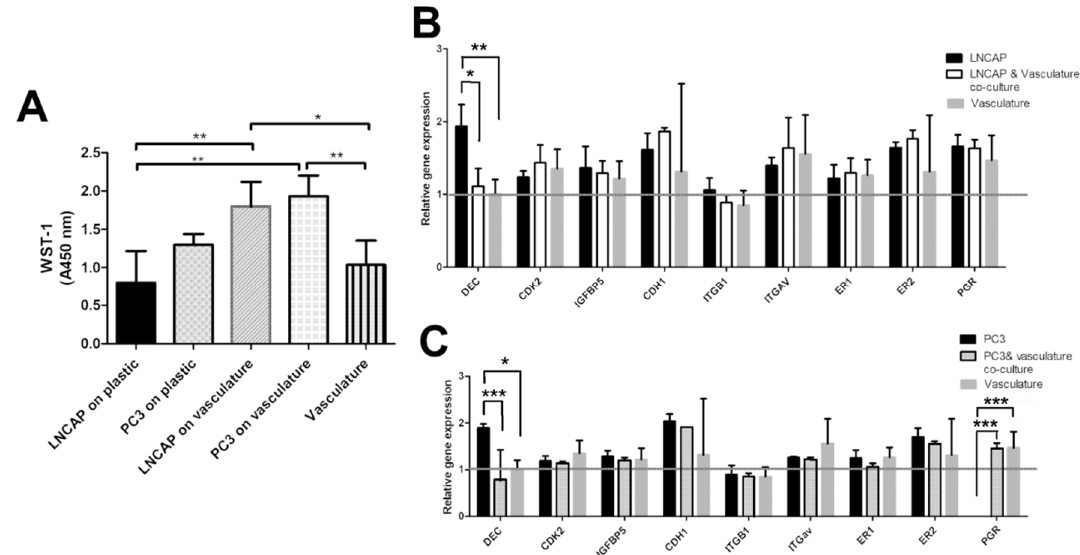
Figure 3. ( A ) Bar graph showing relative cell numbers in different cultures measured with WST-1. Difference between LNCAP and PC3 proliferation is smaller when grown on vasculature compared to plastic. Gene expression results of ( B ) LNCAP and ( C ) PC3 cells grown on plastic and on a vasculature platform. Grey line indicates the no change value (1) after normalization with housekeeping gene RPLP0. Results are obtained from 3 biological replicates (n = 3). Each sample contains total RNA from 6 parallel wells. * p < 0.05, ** p < 0.01 and *** p < 0.001.